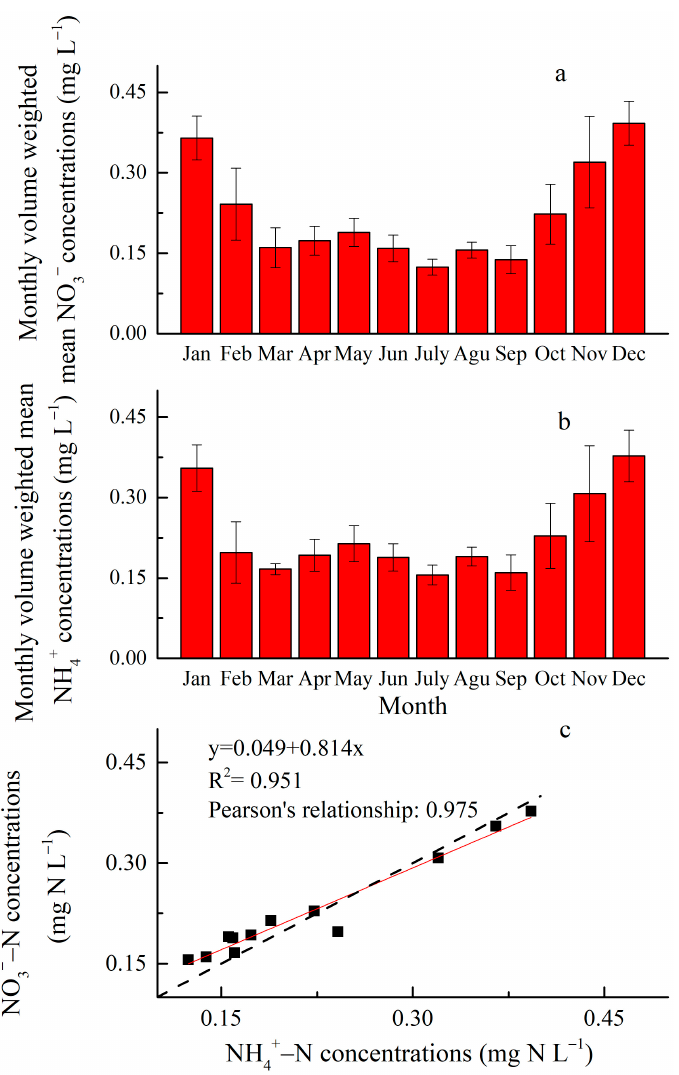
Figure 3. Variation in the monthly volume-weighted mean NO 3 − ( a ) and NH 4+ ( b ) concentrations and their relationship ( c ). In ( c ), the dashed line shows when the NO 3 − concentration is equal to the NH 4+ concentration in precipitation. Black squares above the dashed line mean that NH 4+ -N was the predominant N deposition form. Black squares represent the monthly volume weight mean Nr concentration; the red line represents the fitting line.